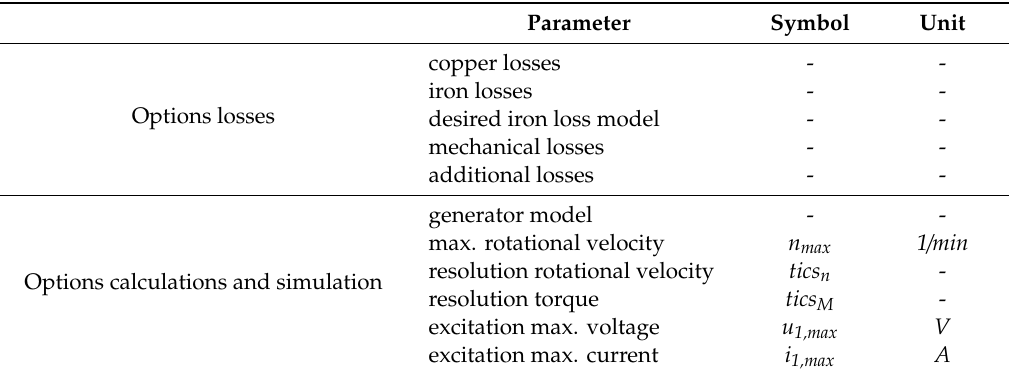
Table 2. Options for analysis in the